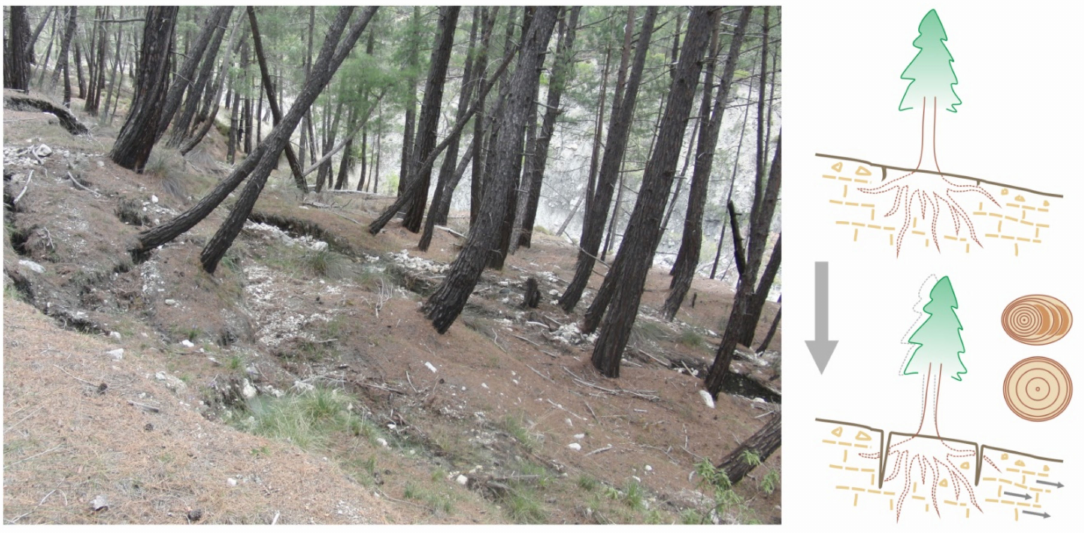
Figure 9. The effect of planar landslide movements to tree